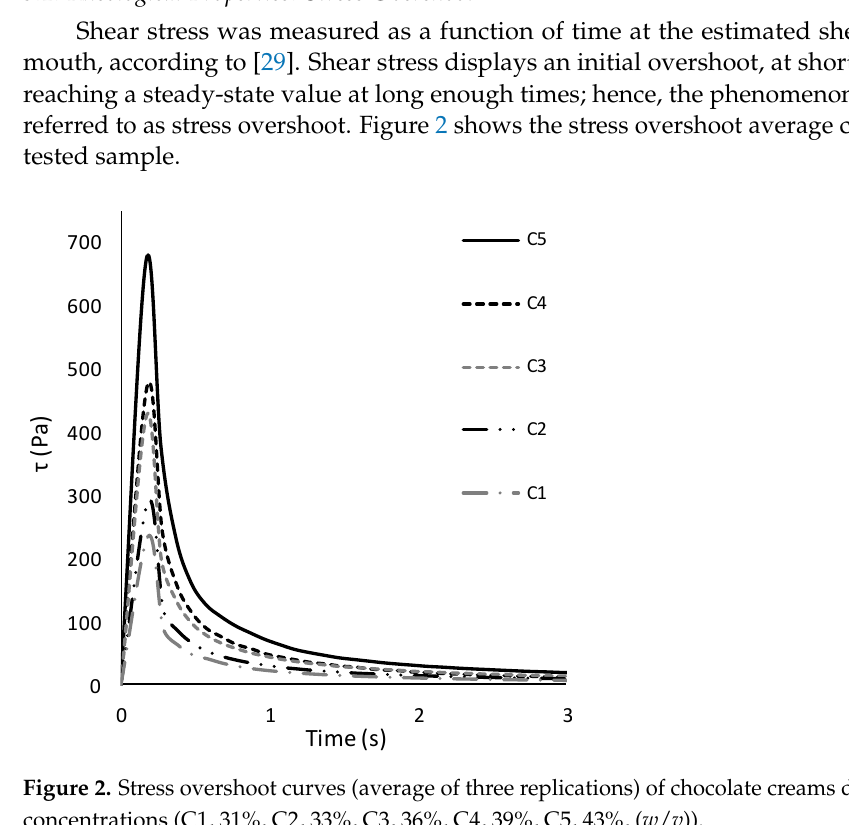
Table 2. Food liking and perceived flowability scores (mean value ± standard error) given by 176 subjects. Sample Code